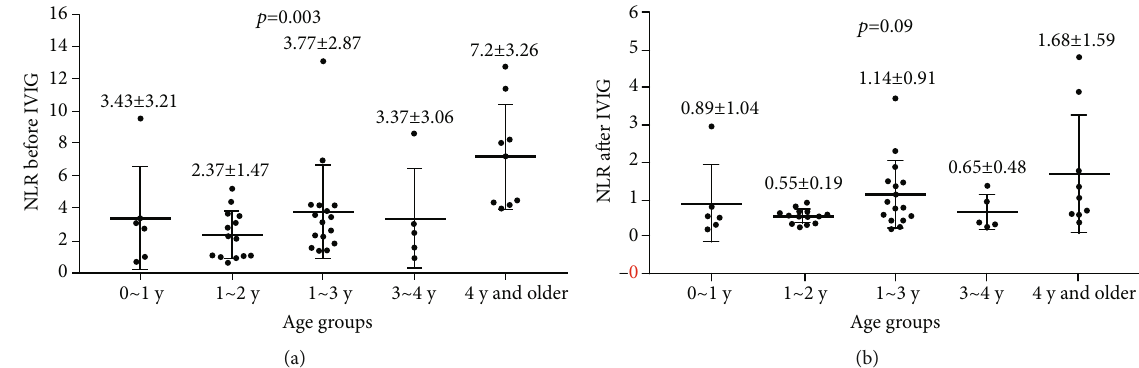
Figure 1: (a, b) NLR before and after IVIG in di ff erent age groups. (a) NLRs prior to IVIG in children with KD were clearly di ff erent among di ff erent age groups. (b) Following IVIG, NLRs were not signi fi cantly di ff erent among di ff erent age groups. NLR: neutrophil/lymphocyte ratio; IVIG: immunoglobulin Table 2: Patients ’ means of neutrophil percentage and lymphocyte percentage before the treatment of IVIG in di ff erent age groups. < 1 y ( n = 6 )